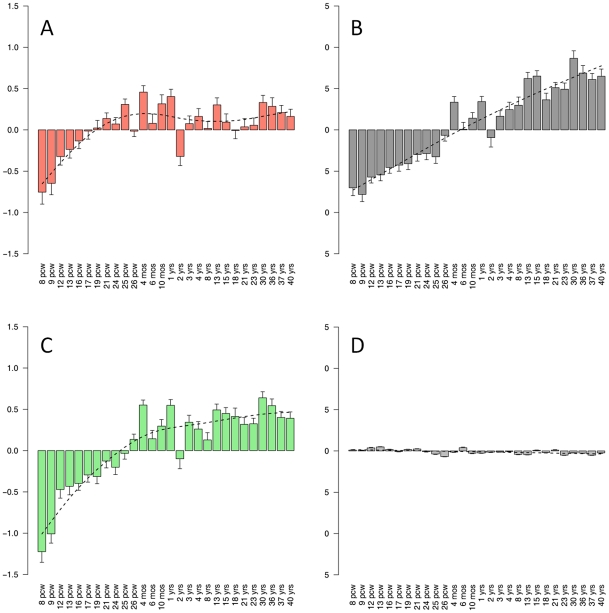
Expression of neuronal modules during developmental stages.The temporal expression pattern is plotted for the modules Salmon (A), Grey60 (B) and Lightgreen (C), along with the pattern of the entire gene set (D). For each module, the average normalized expression across different brain regions for the 50 most connected genes is shown in different ages, overlaid by a smoothed signal (dashed line). pcw, post-conceptional weeks; mos, months; yrs, years.